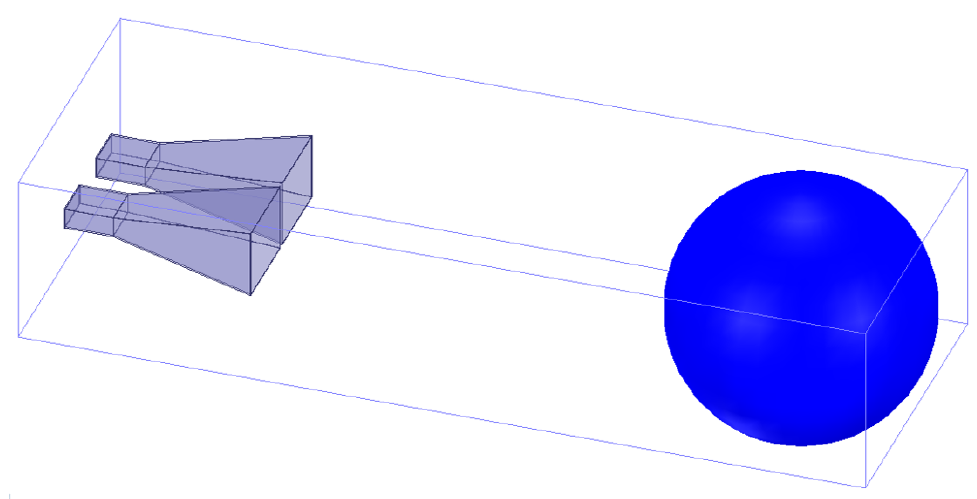
Figure 5. Near-field RCS simulation model.